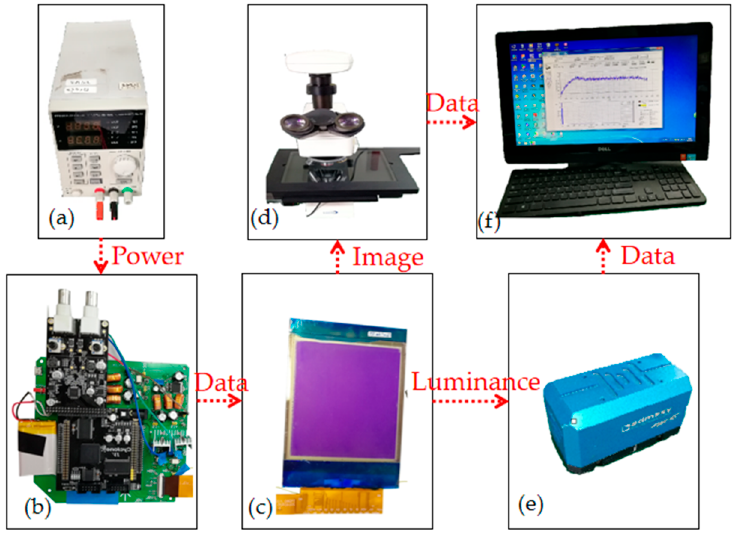
Figure 5. Experimental platform architecture.